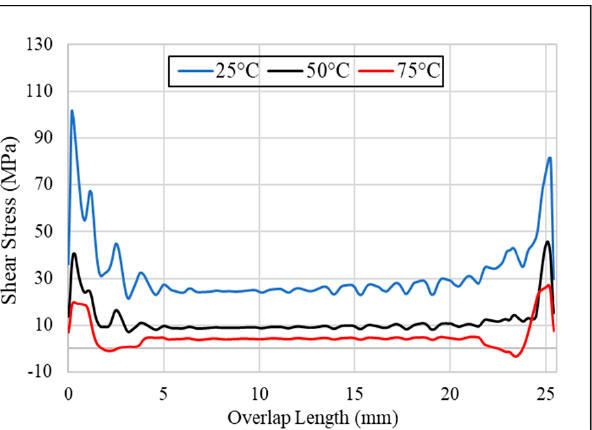
Figure 19. Shear stress distribution location B of SLJ with Al 2 O 3 nanoparticles in the adhesive at different temperatures.